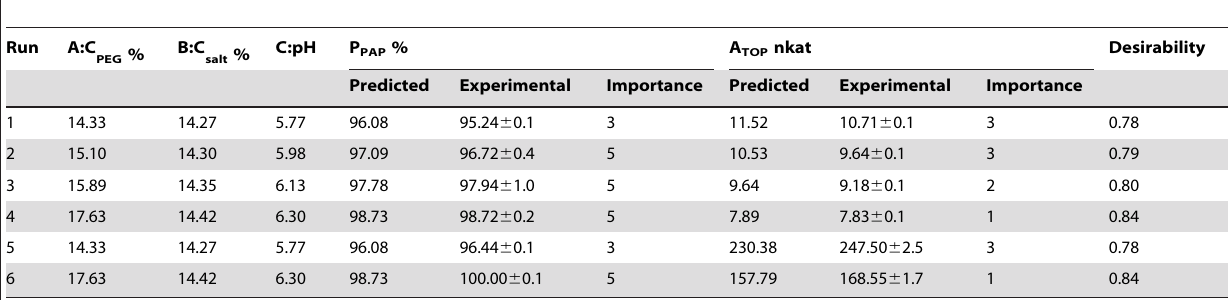
Table 3. Constraints targeting for both P PAP and A TOP and its solutions according to the model.